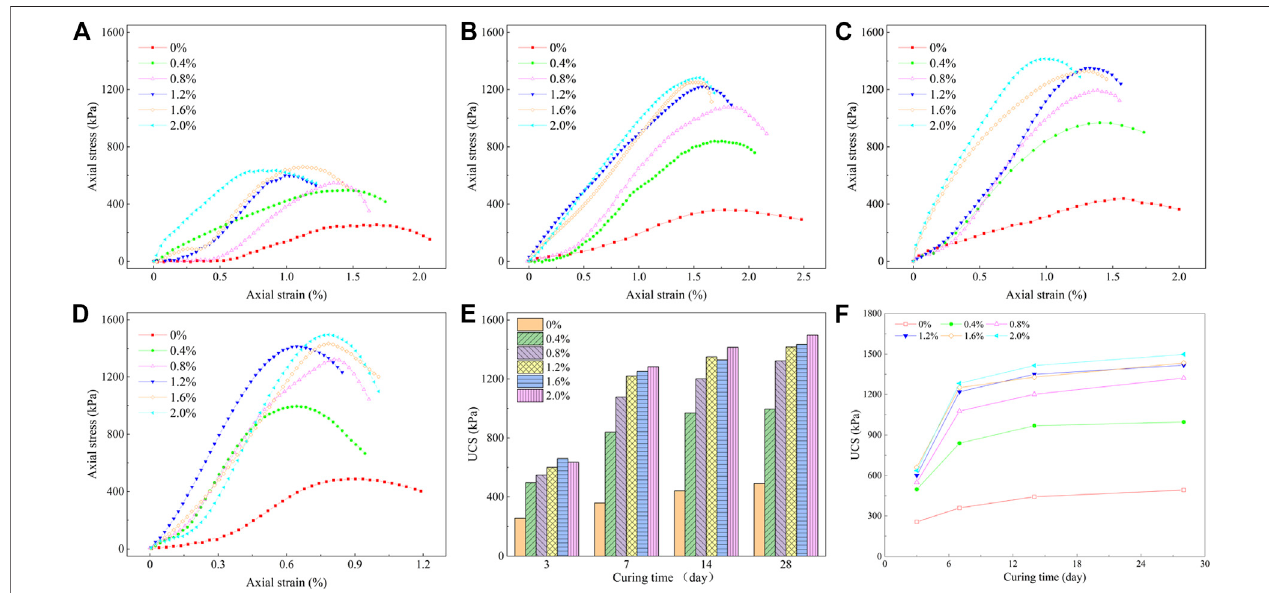
FIGURE 4 | (A – D) Stress – strain curves of cross-linked polymer-treated loess curing for 3, 7, 14, and 28 days (E – F) Uncon fi ned compressive strength of cross- linked polymer-treated loess at different curing times.